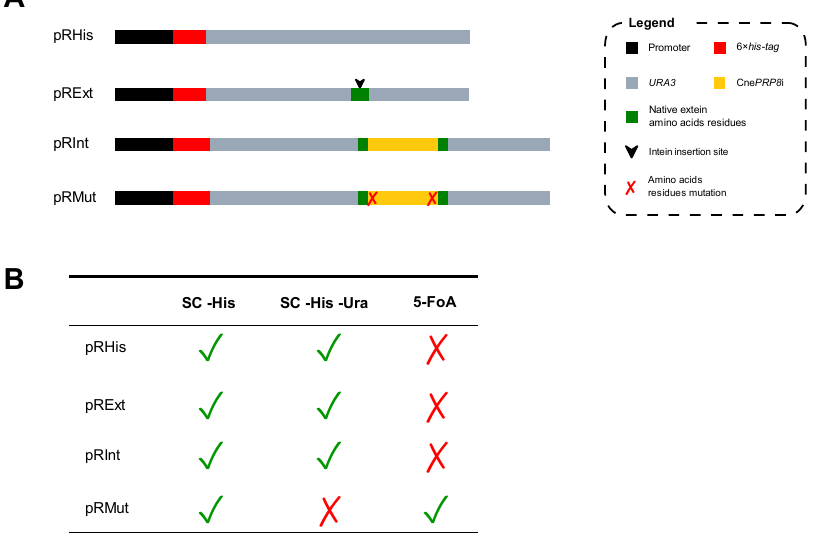
Figure 2. Gene construct overview and growth pattern in different culture media. ( A ) Gene construct maps highlighting their promoters and 6 × his-tag positions, including all the necessary alterations. ( B ) Expected growth pattern for each construct under normal